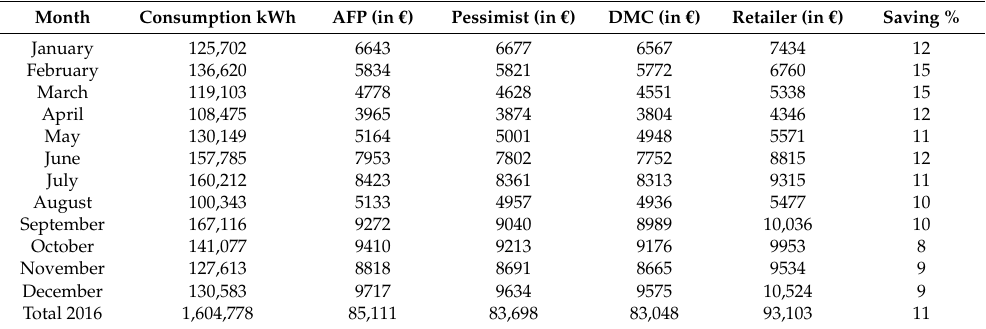
Table 10. Comparison of costs in four cases: average final price (AFP), pessimist, DMC, and